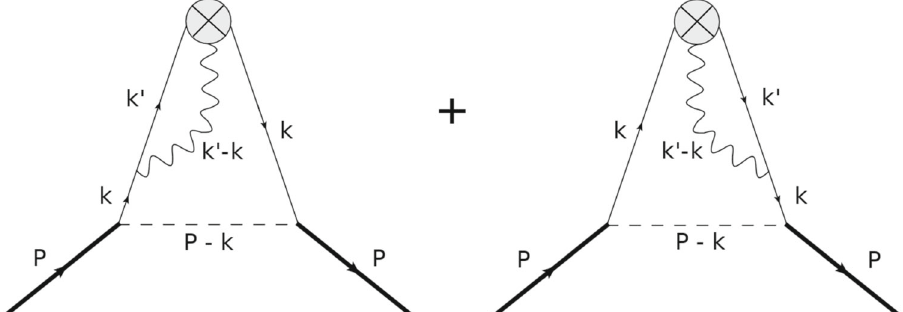
Fig. 5 Sum of the diagrams with a diquark acting as a spectator system while a photon is attached to either the incoming (left) or the outgoing (right)